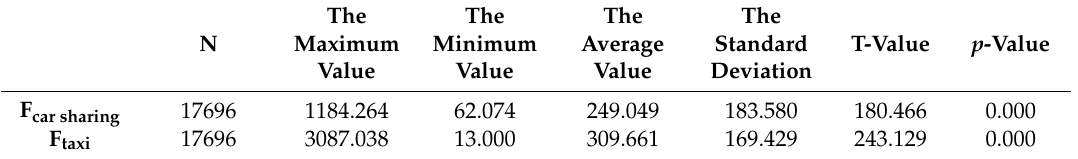
Table A1. The result of the single sample T-test.